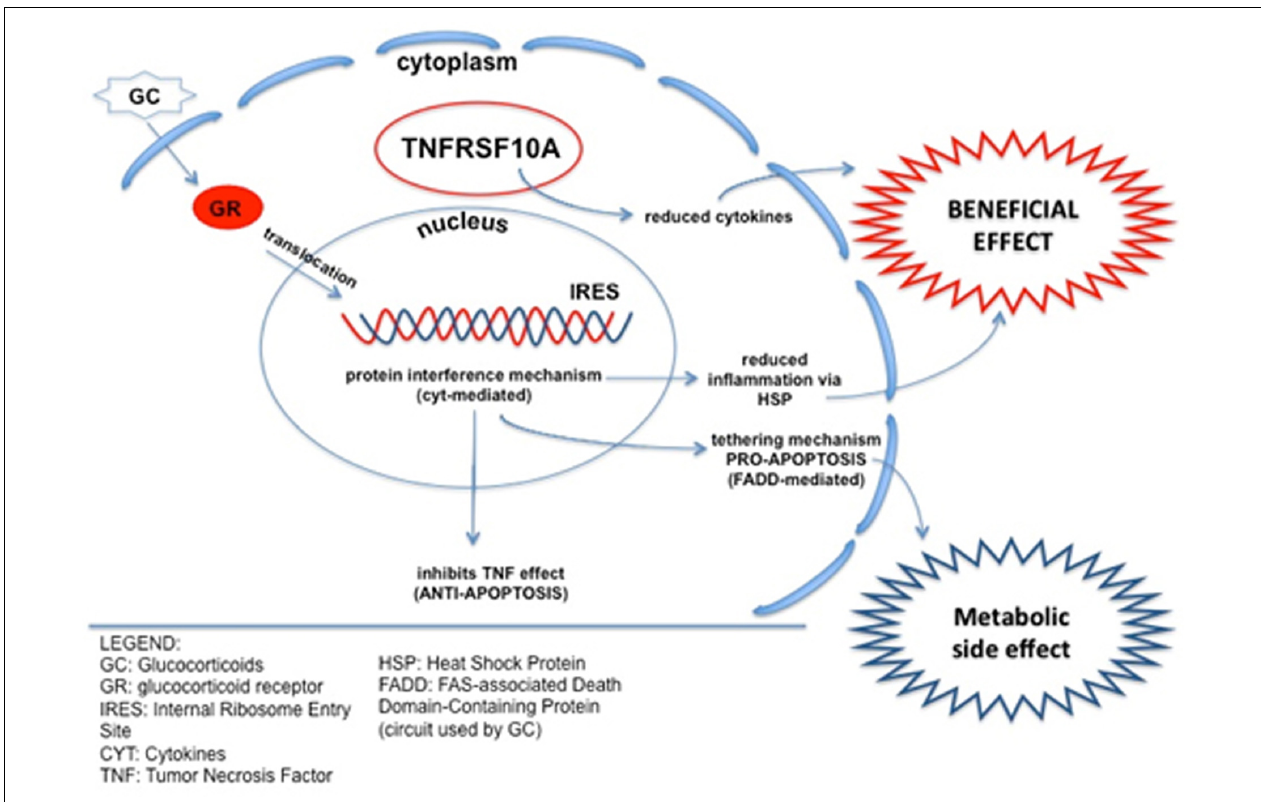
FIGURE 4 | Schematic of crosstalk between the TNF-related pathway and CS response. TNFRSF10A is involved in inducing apoptosis, but also in suppressing inflammation, reducing pro-inflammation cytokines. As a possible underlining mechanism, TNFRSF10A can reduce the apoptotic effect of CS, via IRES elements, maintaining the anti-inflammatory action and potentially conferring a better CS response to HR patients. CS, Corticosteroids; GR, Glucocorticoid Receptor; IRES, Internal Ribosome Entry Site; CYT, Cytokines; TNF, Tumor Necrosis Factor; HSP, Heat Shock Protein; FADD, FAS-associated Death Domain-containing protein (circuit used by